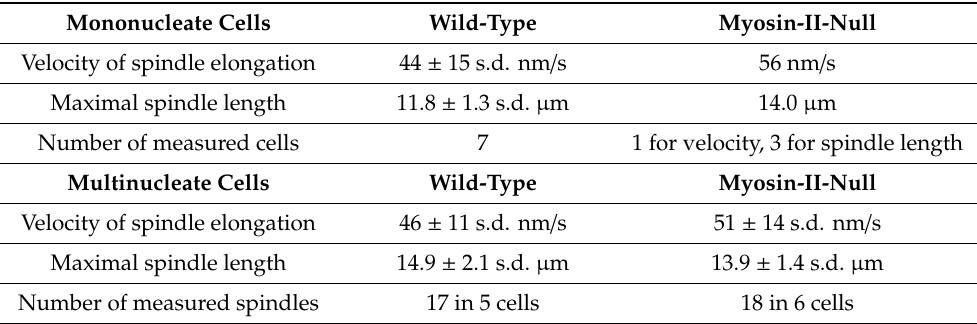
Table 1. Mitotic spindles in wild-type and myosin-II-null